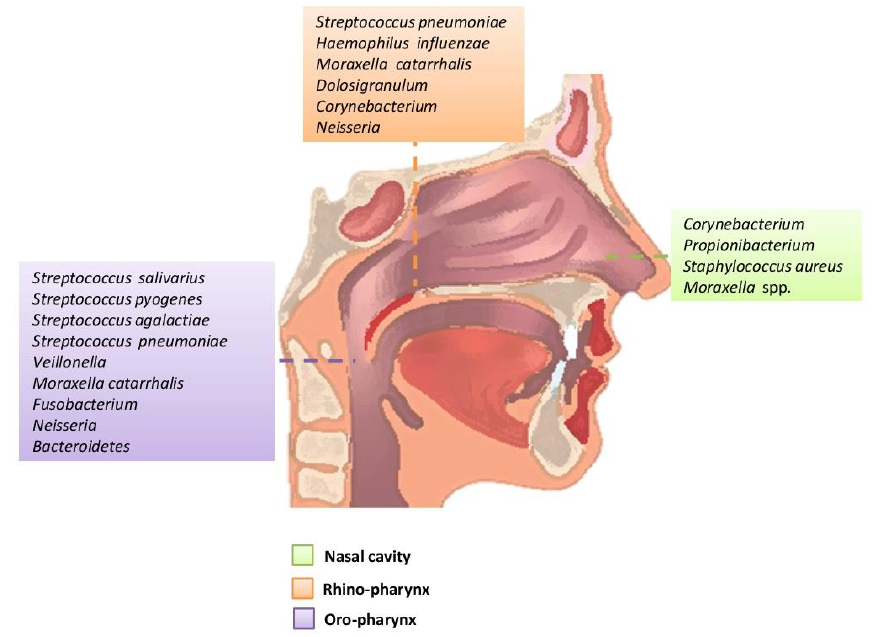
Figure 1. Main bacteria genera and microbiome species of an adult in the upper respiratory tract.